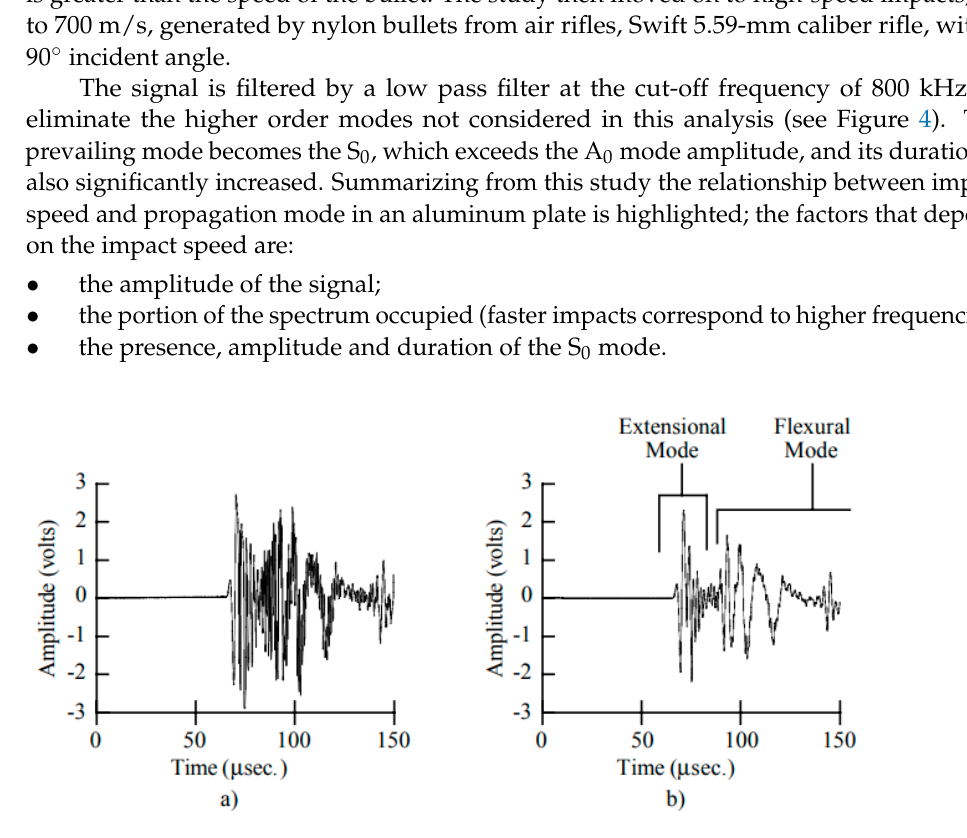
Figure 4. Signals generated from a high-velocity impact: ( a ) original signal without filtering, ( b ) same signal after 800 kHz low-pass filtering